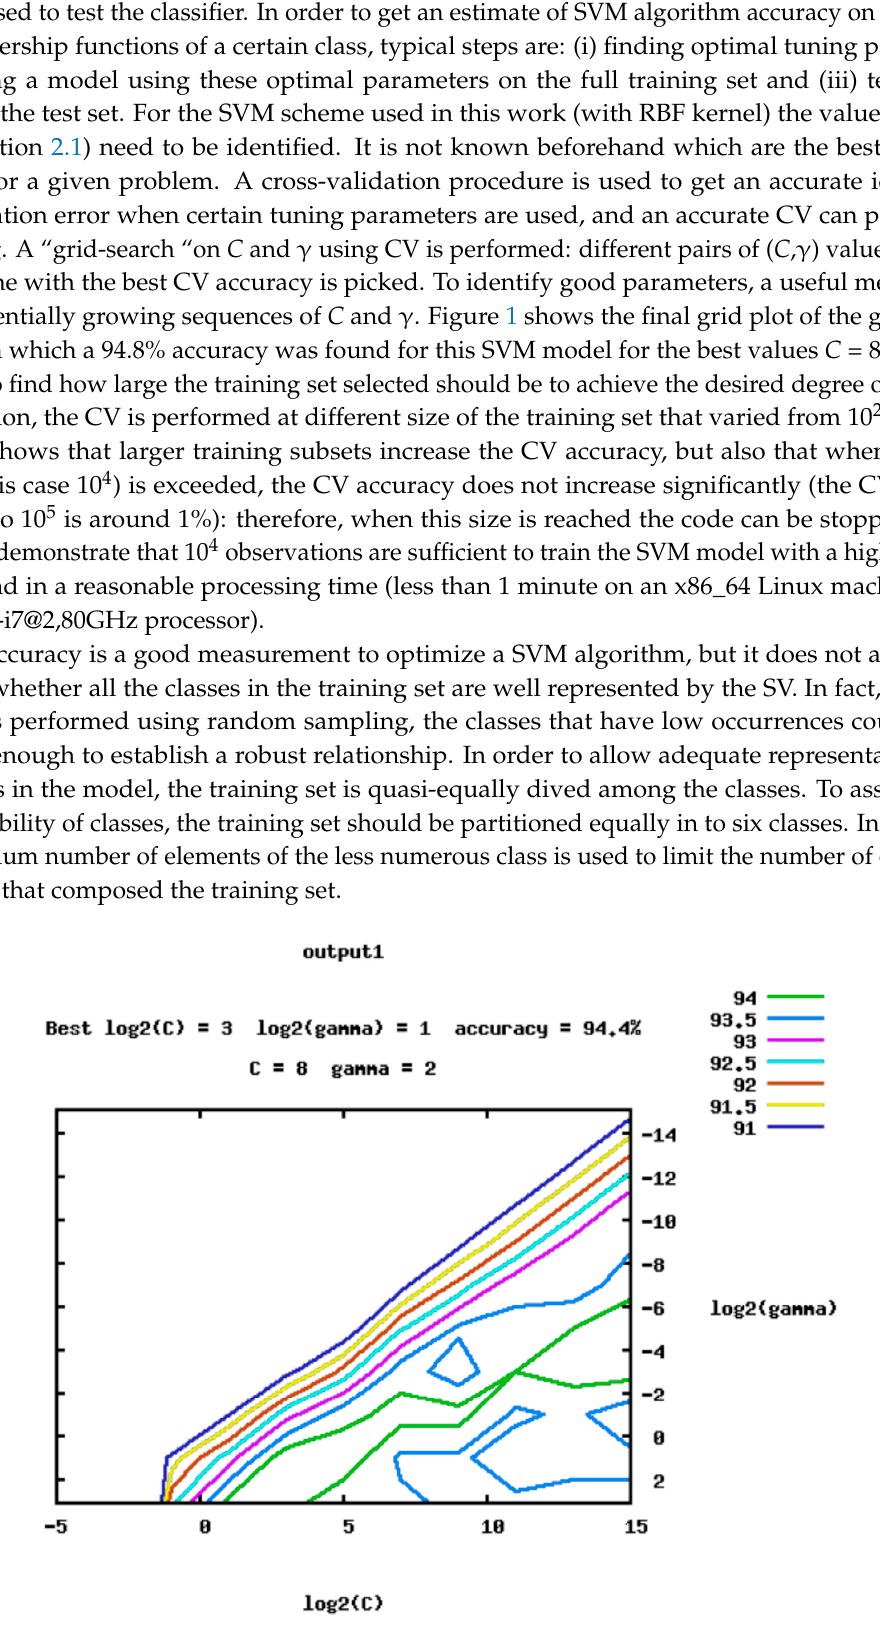
Figure 1. Example of parameter estimation (C and γ ) using a grid search process during the cross-validation.